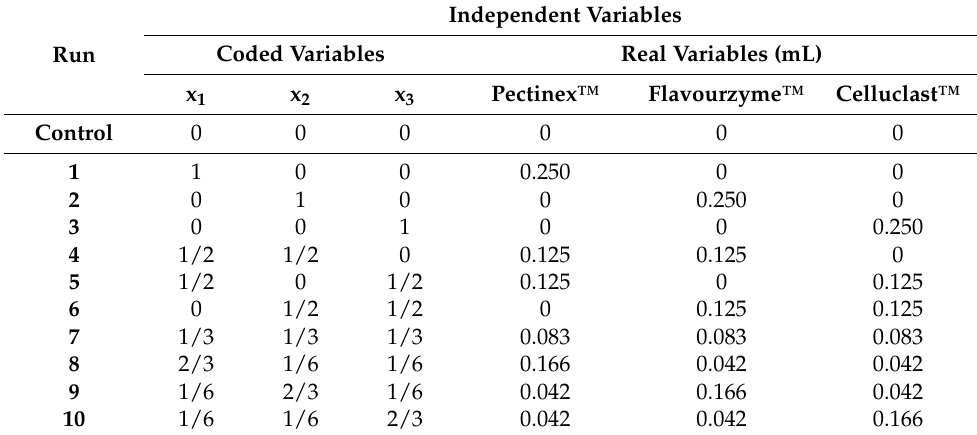
Table 1. Matrix of the simplex centroid design used for extraction of antioxidant compounds of banana bracts from Maç ã , Prata and Nanica varieties using different enzymatic preparations. Independent Variables Coded Run